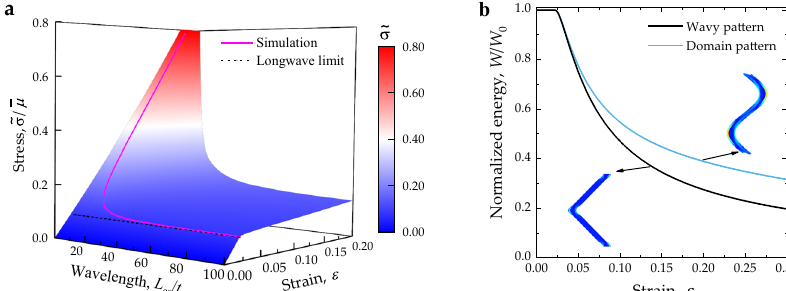
Fig. 3 Mechanism of the formation of domain patterns. a Stress-scape of buckled laminate, the magenta curve refers to the onset of instability at the given buckled wavelength. b Comparison of stored elastic energy in the laminate with domain and wavy modes. The results are given for the laminate with c ð l Þ ¼ 0 : 5 , μ ð l Þ = μ ð m Þ ¼ 49